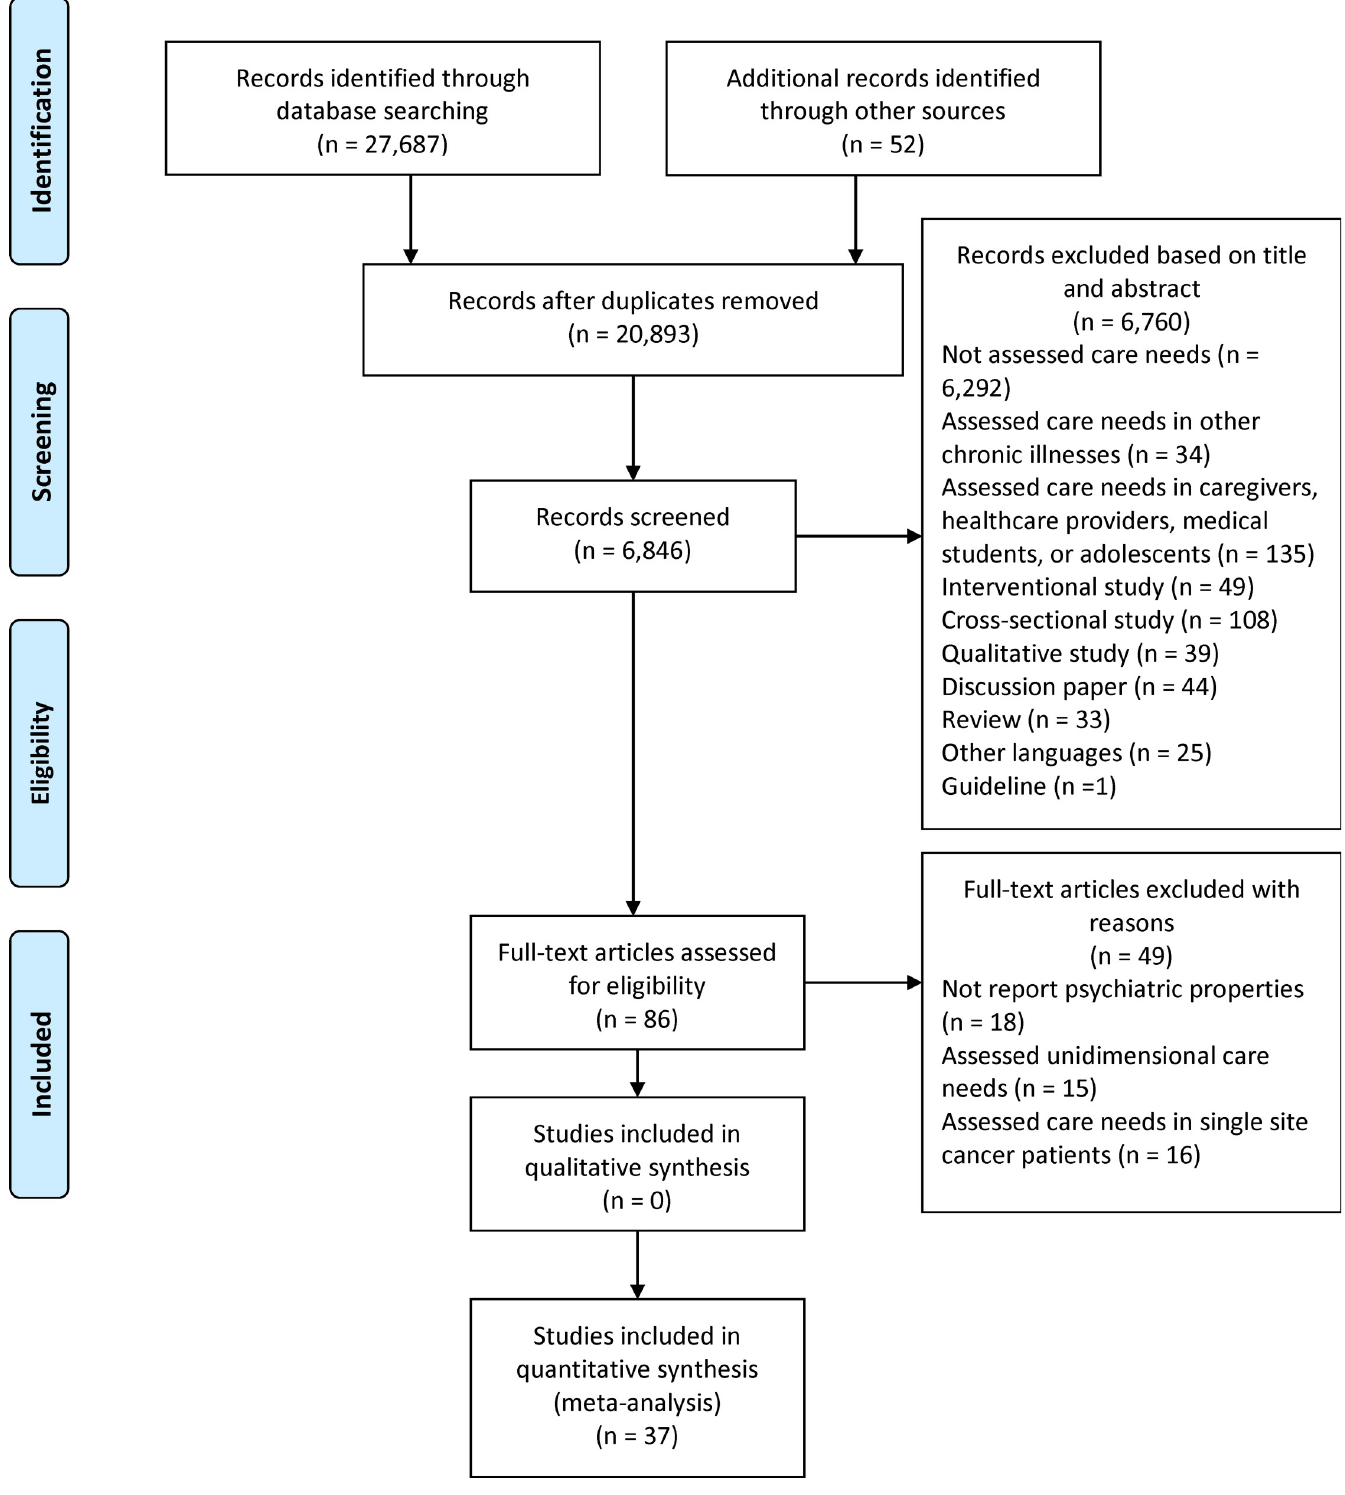
Fig 1. Selection of studies flowchart.